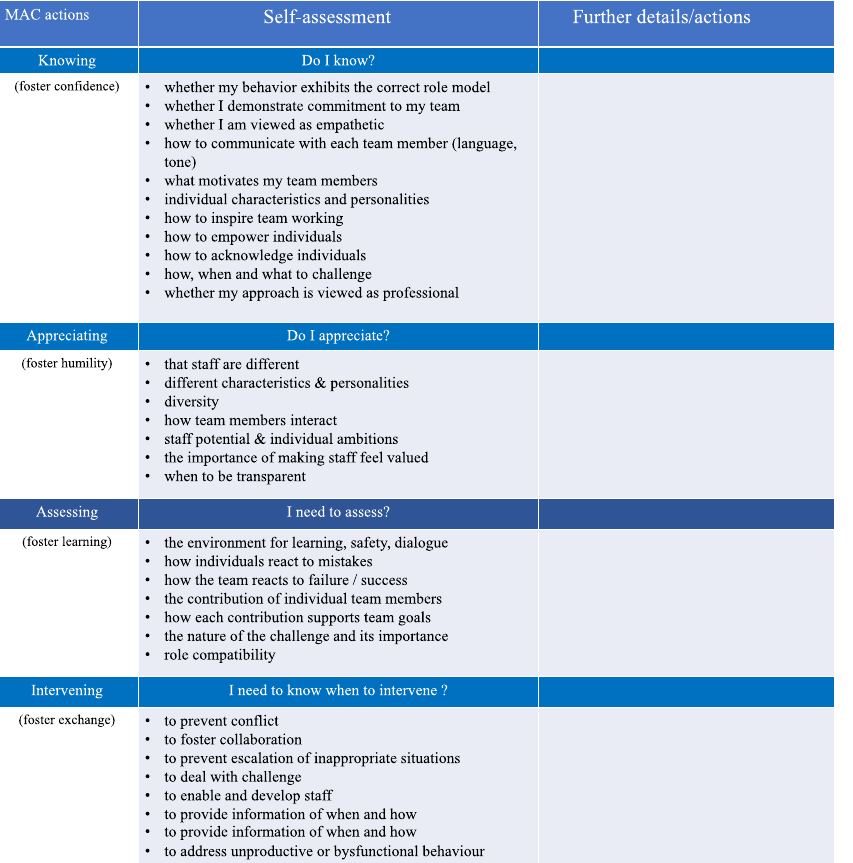
Table II. A practical